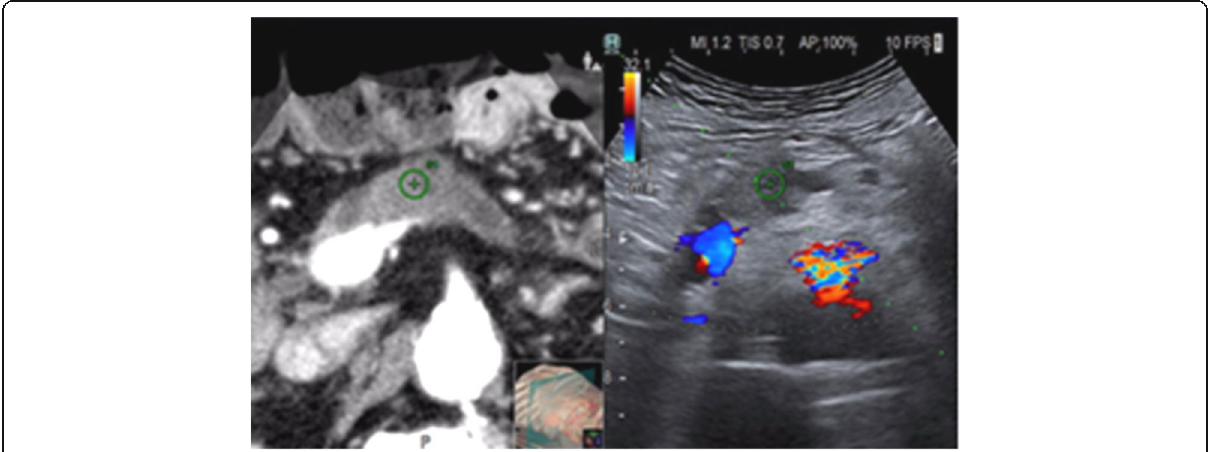
Fig. 4 CT-US fusion imaging. Radiofrequency ablation planning of pancreatic neck carcinoma, hypodense on CT and hypoechoic on Doppler US (performed to highlight the peripancreatic